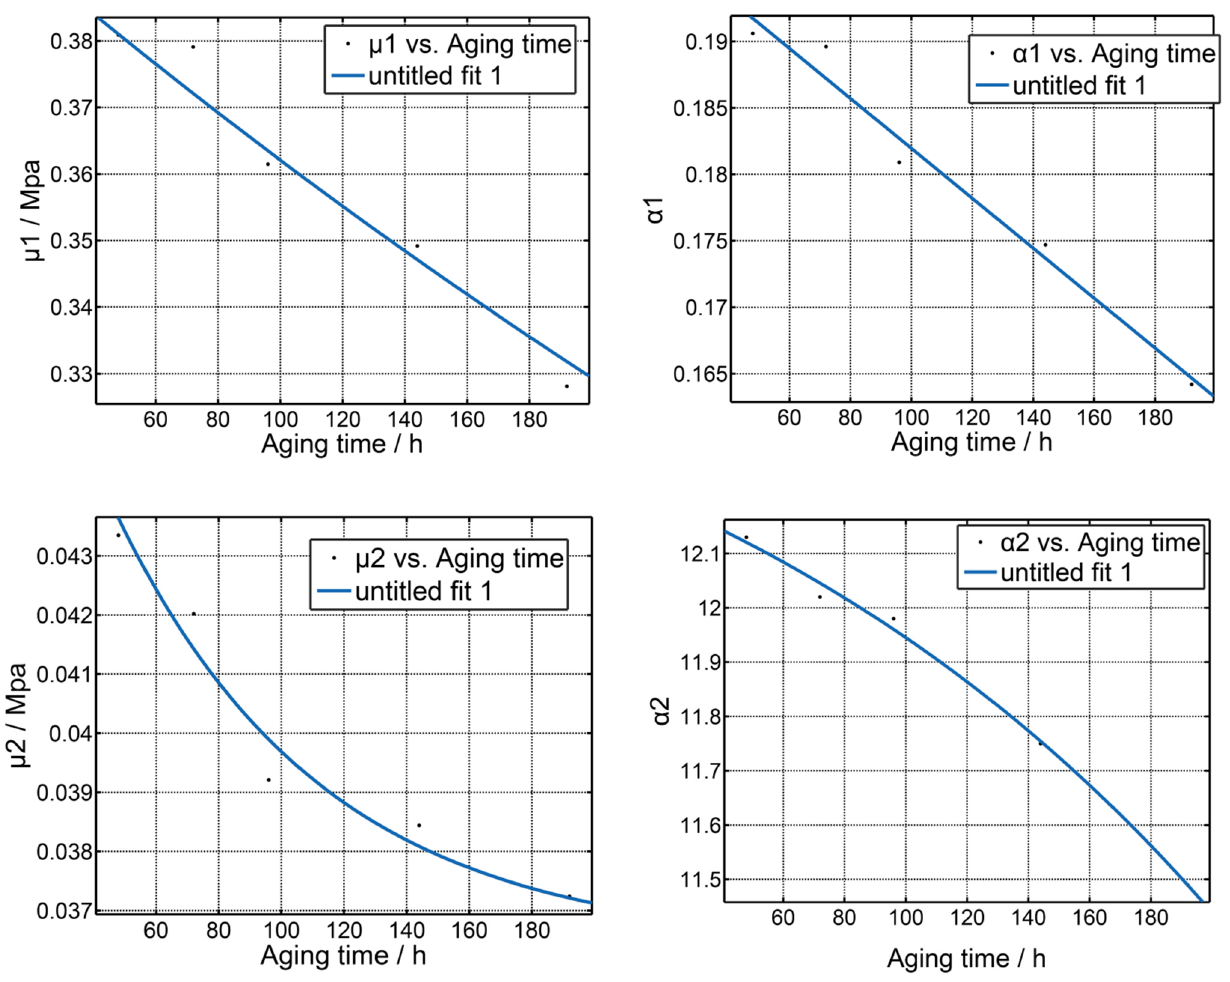
Figure 6. The fitting results of the hyper-foam model parameters as functions of aging time: µ 1 , α 1 , µ 2 , and α 2 .